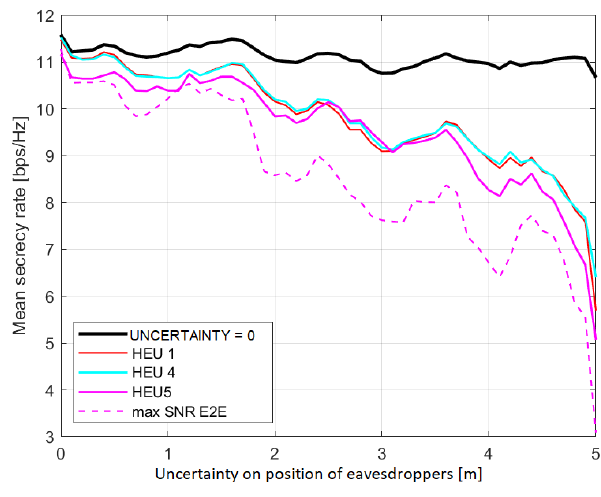
Figure 6. Average secrecy rate versus uncertainty on eavesdroppers’ position.